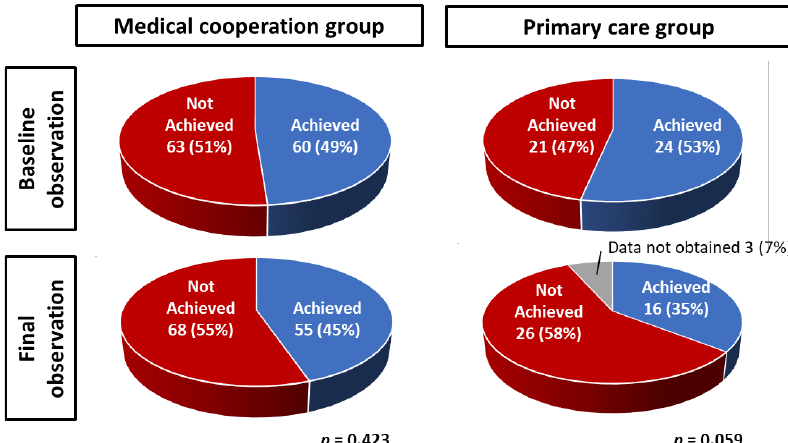
Figure 4. Effect of medical cooperation on achievement of blood pressure control. The target value of blood pressure was defined as systolic BP less than 130 mmHg and diastolic BP less than 80 mmHg [18]. At baseline, the medical cooperation group and the primary care group had similar rates of achieving blood pressure control targets.